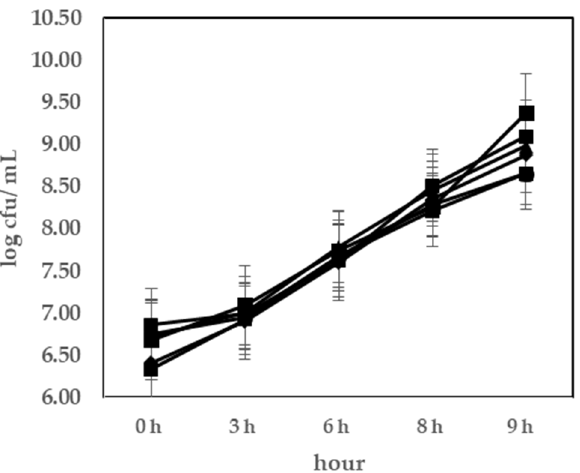
Figure 2. LAB bacterial cell numbers during fermentation at 40 °C. ◆ , control yoghurt without probiotics (C); ■ , L. rhamnosus GG KCTC 12202BP(T1); ▲ , L. plantarum KU15003 (T2); ✕ , L. plantarum KU15031(T3); ✳ , L. plantarum NK181(T4); ● , L. delbrueckii KU200171(T5).